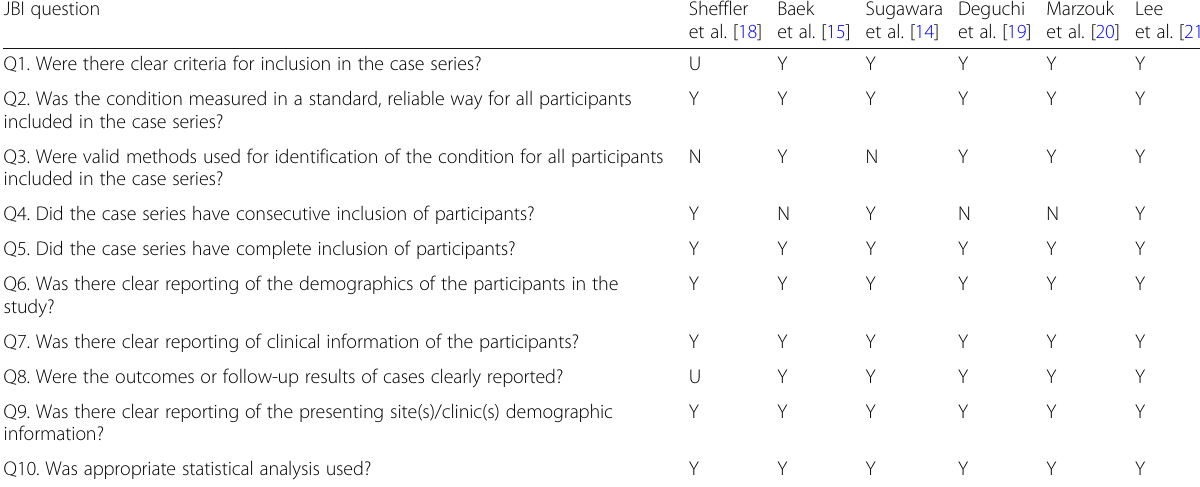
Table 3 The Joanna Briggs Institute critical appraisal checklist tool for case series studies applied to all of the included articles JBI